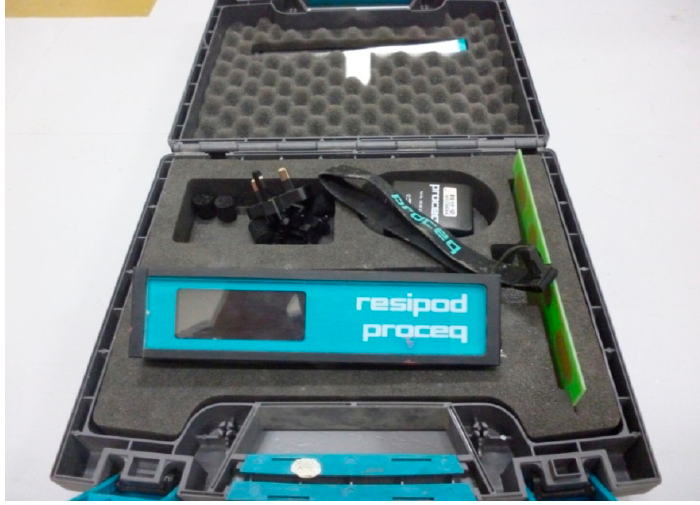
Figure 8. Four-pole resistance measuring instrument.